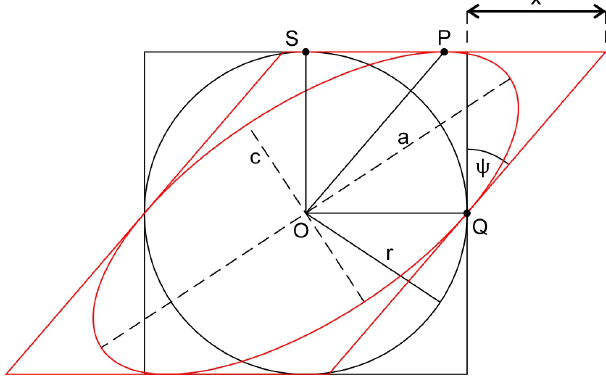
Figure A4. Geometry of the ellipse from Fig. A3, and its angle φ with the shear plane, considering Cartesian coordinates parallel to semiaxes ac